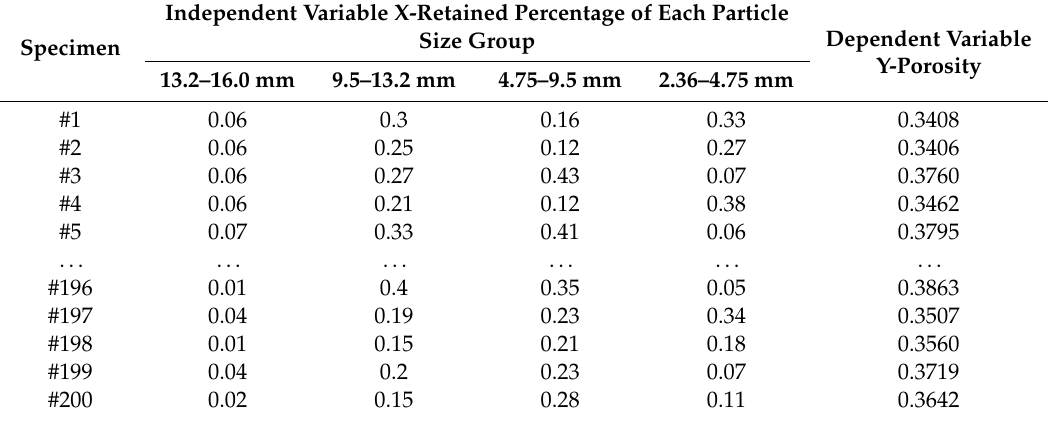
Table 6. Recorded data of Gradation-13.